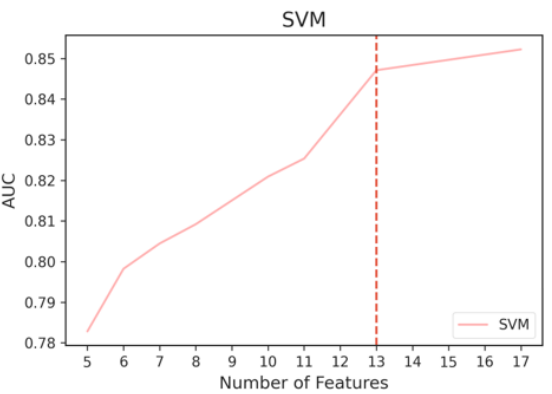
Figure 12. Cutoff point for SVM where performance tapers off when adding more MRMR features.